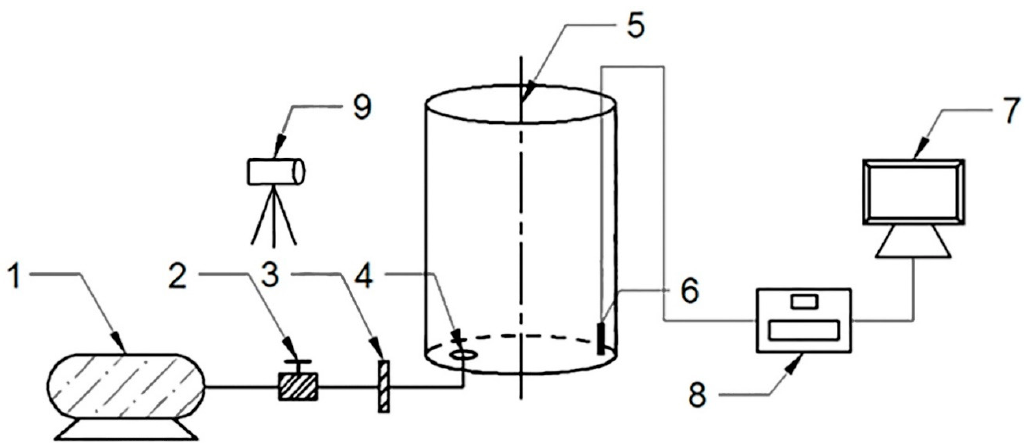
Figure 2. Water model experiment setup: ( 1 ) Air compressor; ( 2 ) pressure gauge; ( 3 ) air flow rate controller; ( 4 ) porous plug; ( 5 ) model ladle; ( 6 ) conductivity probe; ( 7 ) computer; ( 8 ) conductivity meter; ( 9 ) high speed digital camera.